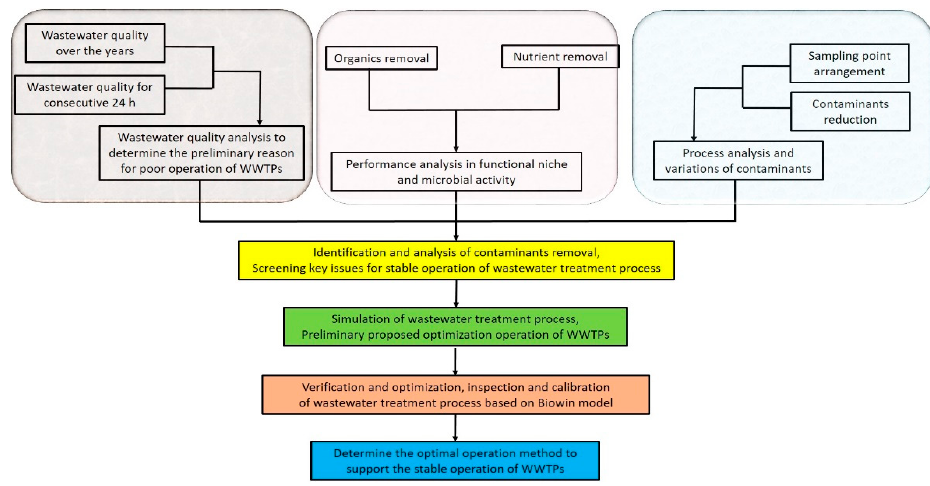
Figure 1. Diagnostic method for the operation of WWTPs.